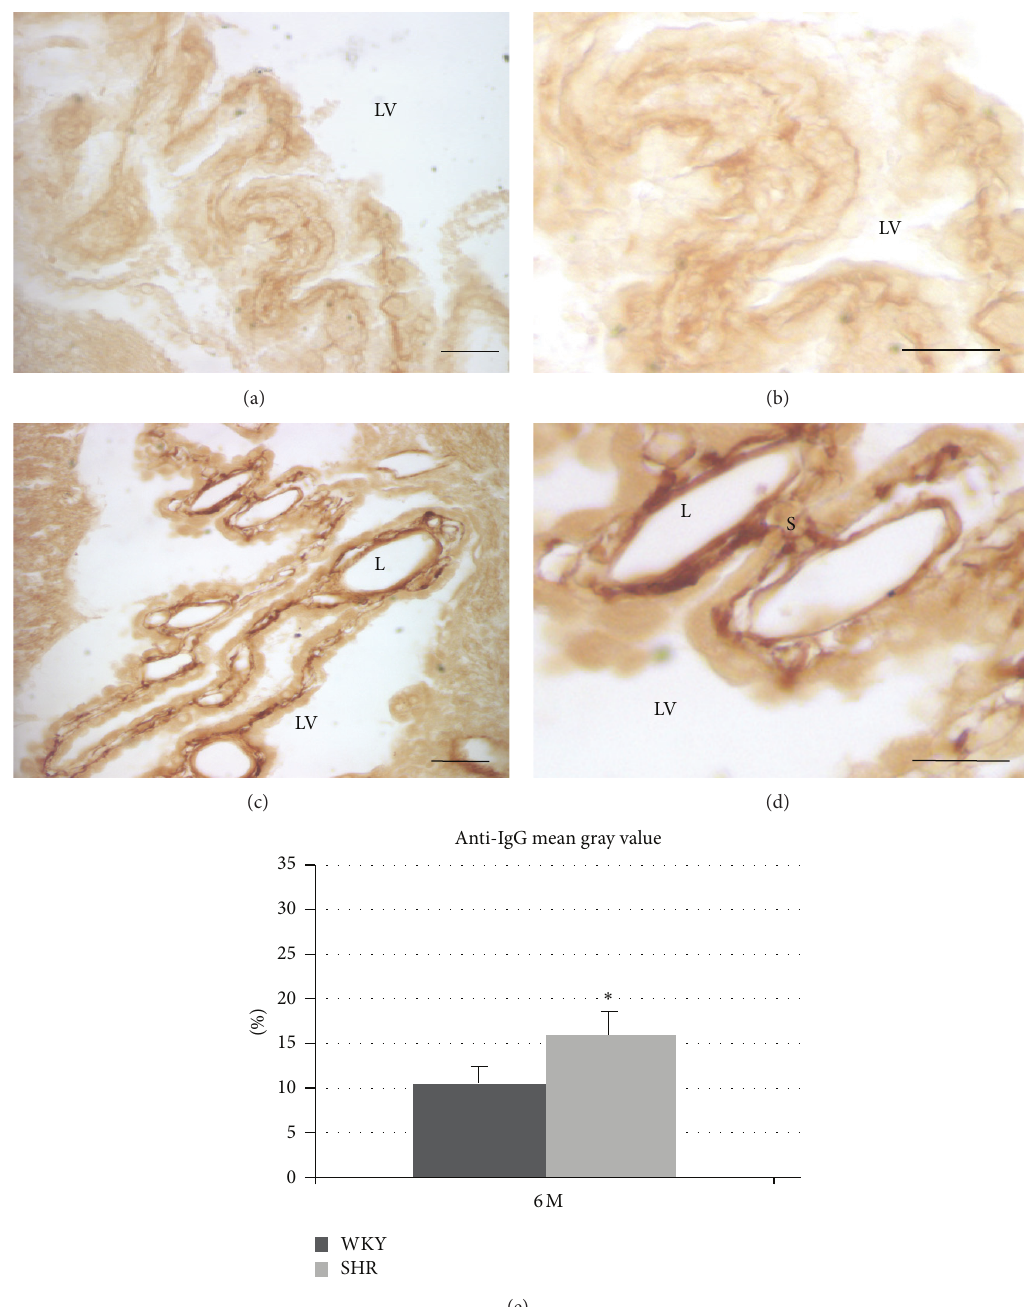
(e) F 2: Coronal sections of rats showing choroid plexus the lateral ventricle showing of IgG immunostaining. (a) and (b): WKY rats, (c) and (d): SHR rats, (e): histogram showing the immunohistochemical �uanti�cation (mean gray value) for IgG in the choroid plexus of the lateral ventricle.Abbreviations: L: lumen, EP: epithelium of the choroid plexus, S: stroma, and LV: lateral ventricle. (escale bar: 30 𝜇𝜇